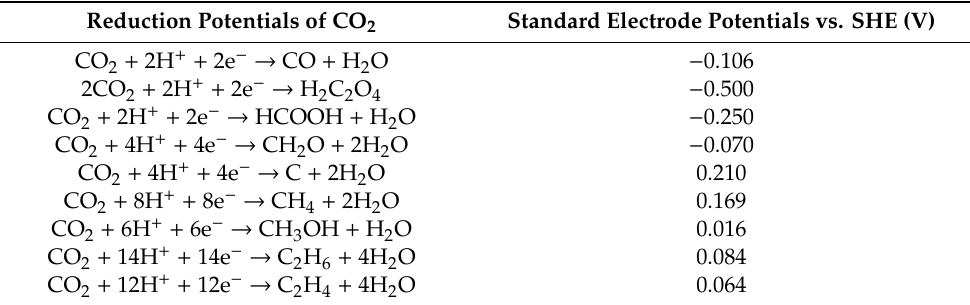
Table 9. Standard electrochemical potentials for CO 2 reduction